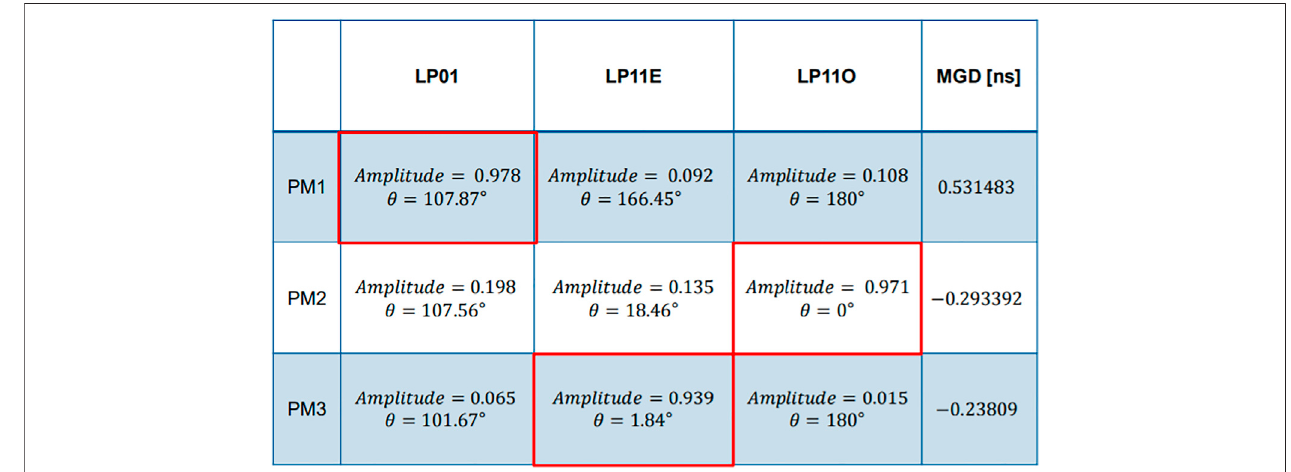
FIGURE 8 | Values of the determined Principal